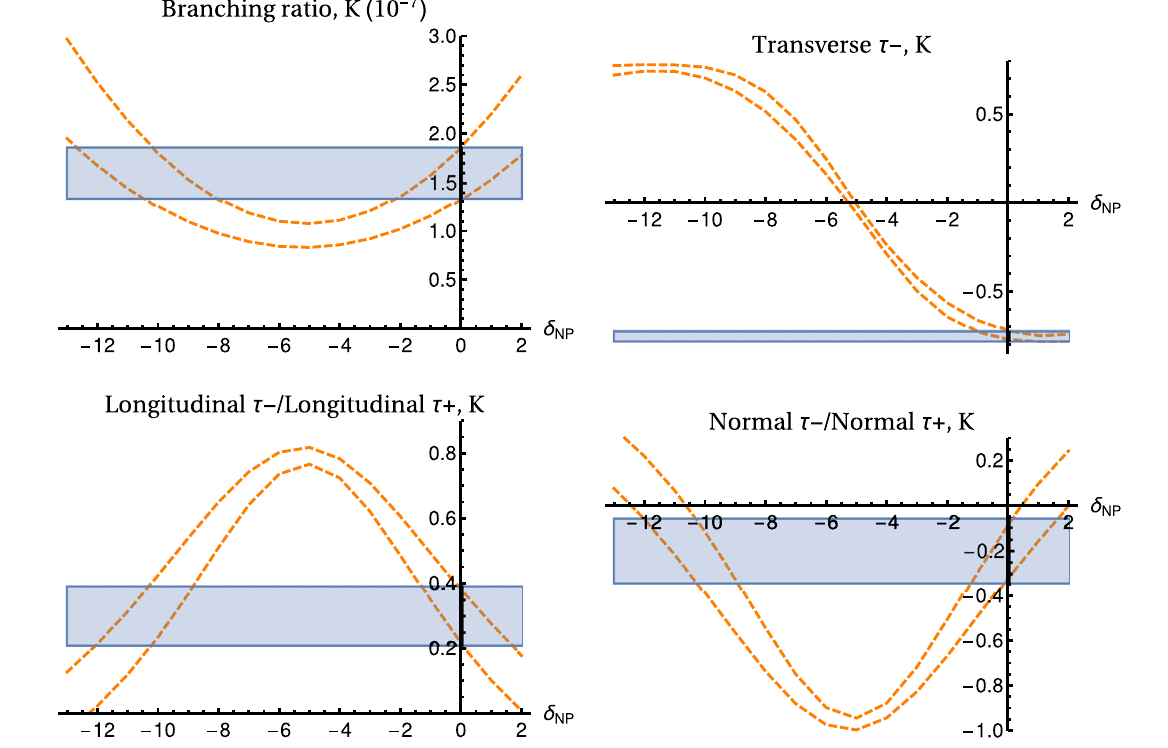
in the SM (solid, filled blue, independent on the value of δ NP ) and in the NP under consideration (dashed orange). The blue band corresponds to the errors seen in Table 2, which are recalculated for